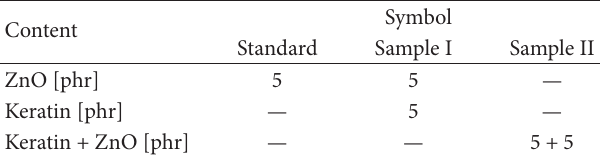
Table 1: The compositions of the mixes under